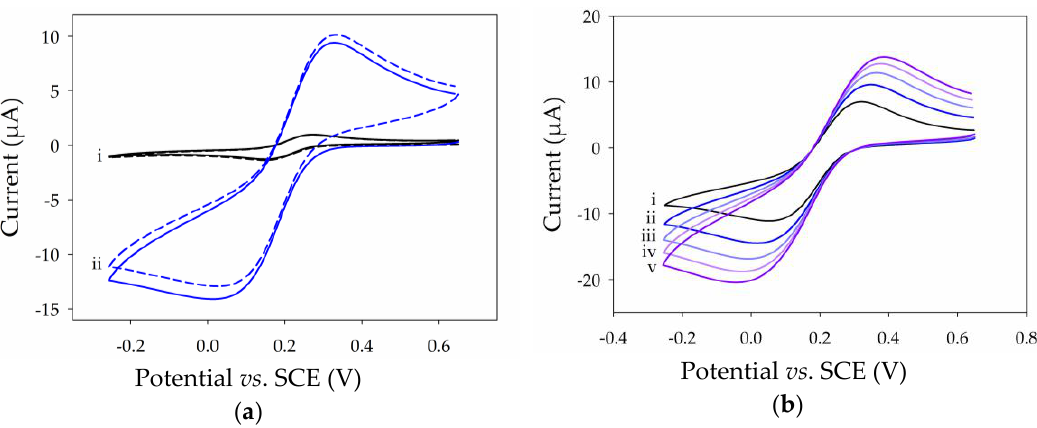
Figure 3. Cyclic voltammograms recorded in 1 mM K 3 Fe(CN) 63 − in 0.1 M PB pH 7 with 0.1 M KCl showing ( a ) the first two cycles at 100 m · Vs − 1 of the (i) Pt electrode (black) and (ii) Pt-MWCNT electrode (blue); and ( b ) the first cycle at (i) 20 m · Vs − 1 , (ii) 40 m · Vs − 1 , (iii) 60 m · Vs − 1 , (iv) 80 m · Vs − 1 , and (v) 100 m · Vs − 1 .